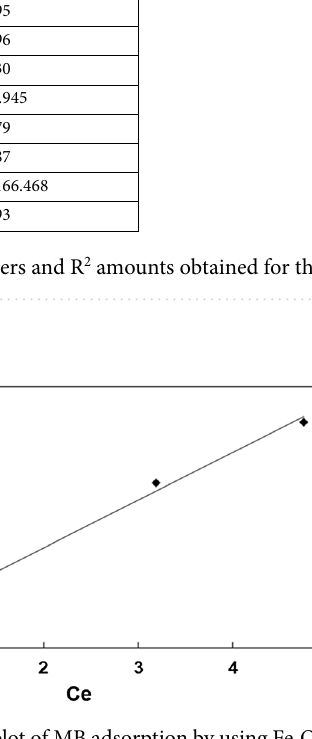
Figure 18. The Langmuir plot of MB adsorption by using Fe 3 O 4 @Void@m.SiO 2